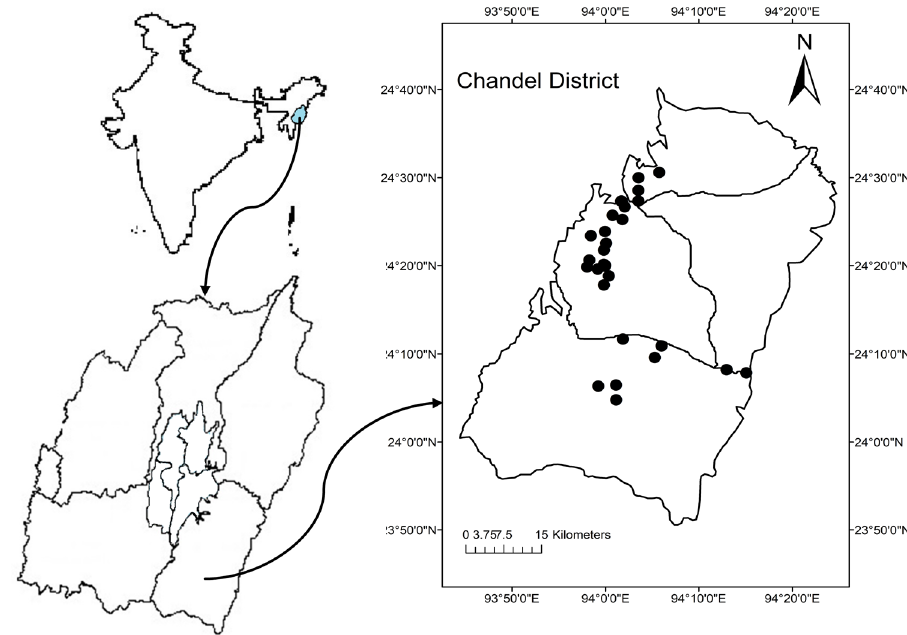
Fig. 1 Map shows the sampling locations of the study